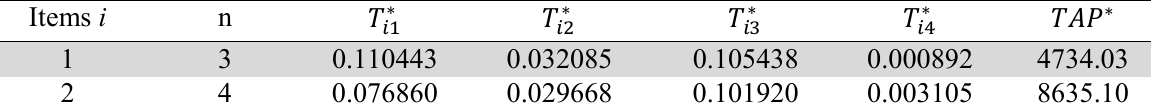
Optimal solutions for examples